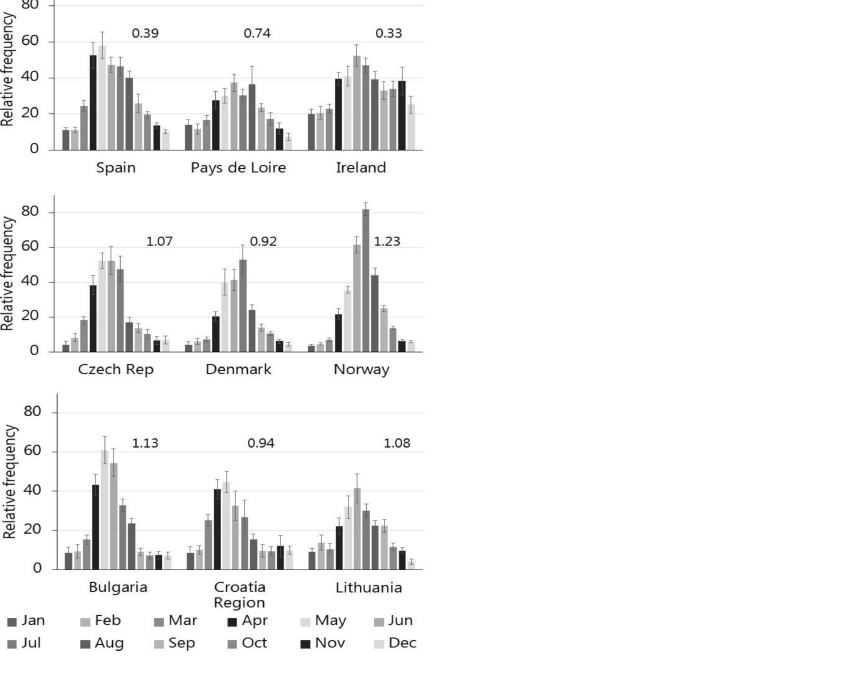
Figure 3. The relative monthly variation in tick search-terms in nine different countries/region in Europe in the period 2007 to 2019 (Mean ± SE).